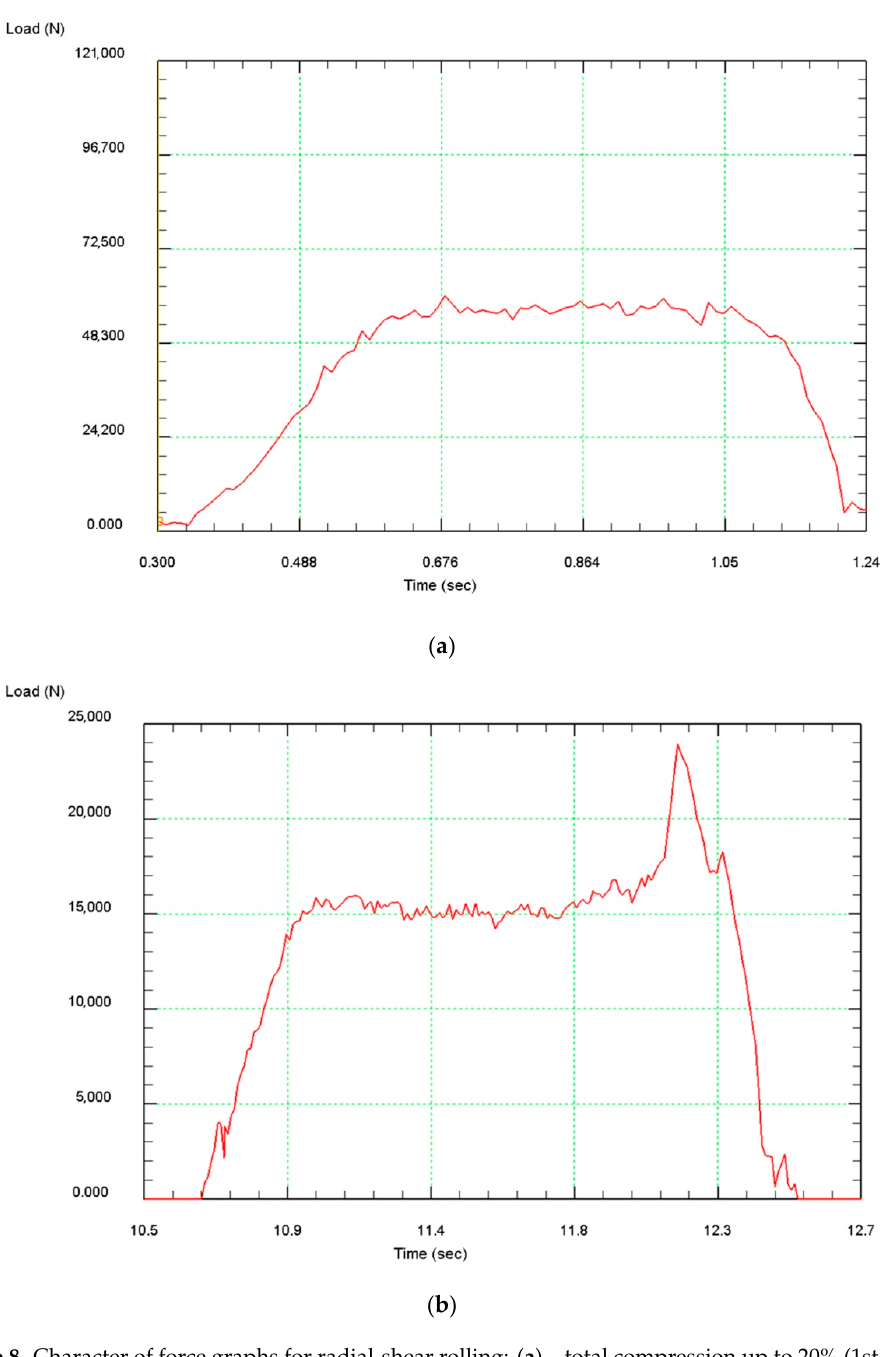
Figure 8. Character of force graphs for radial-shear rolling: ( a )—total compression up to 20% (1st pass); ( b )—total compression over 20% (8th pass).